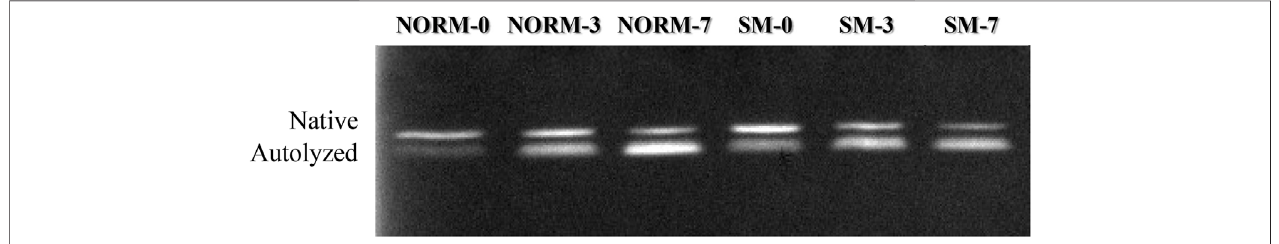
FIGURE 3 | Representative casein zymogram according to muscle condition (M — normal, NORM; Spaghetti Meat, SM) and postmortem time (T — 0, 3, 7 days).